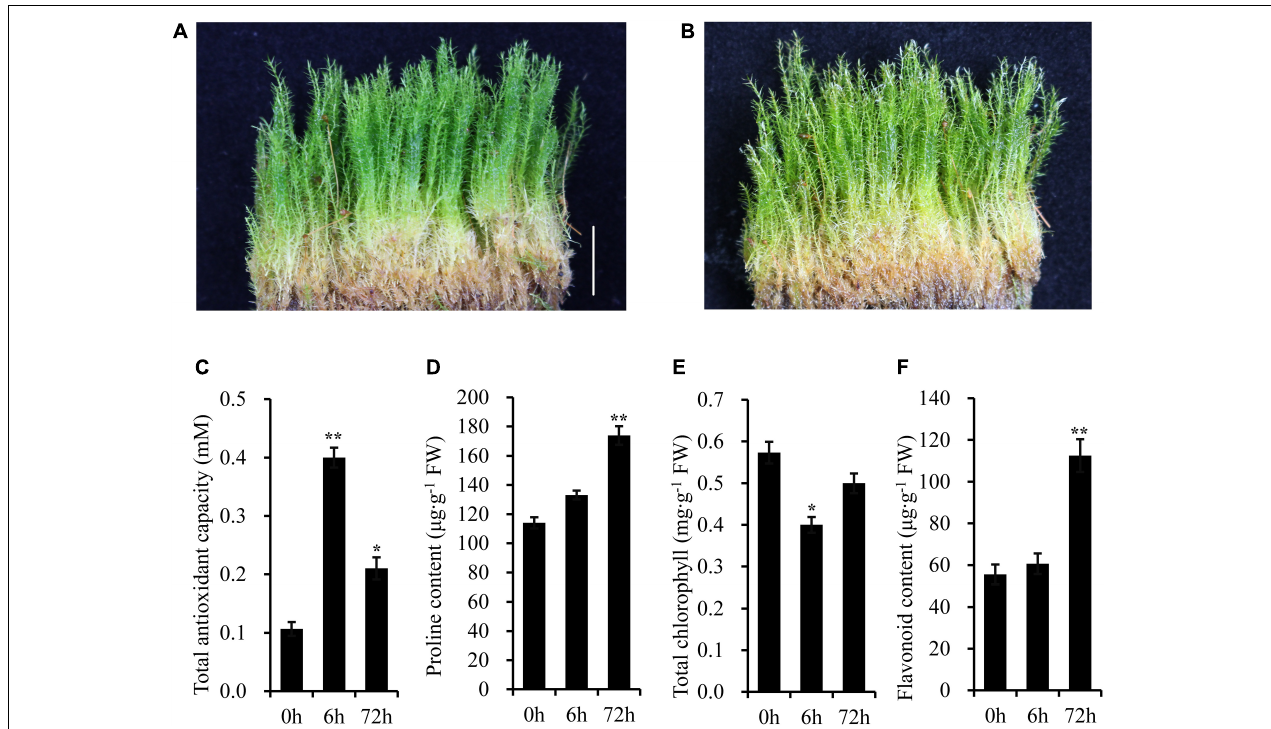
FIGURE 2 | The Antarctic moss L. pyriforme can tolerance strong UV-B radiation. (A) Photo of L. pyriforme under nornal condition. (B) Morphological changes of L. pyriforme under UV-B radiation. (C–F) The physiological parameters of L. pyriforme under UV-B radiation. Bar = 1.0 cm.